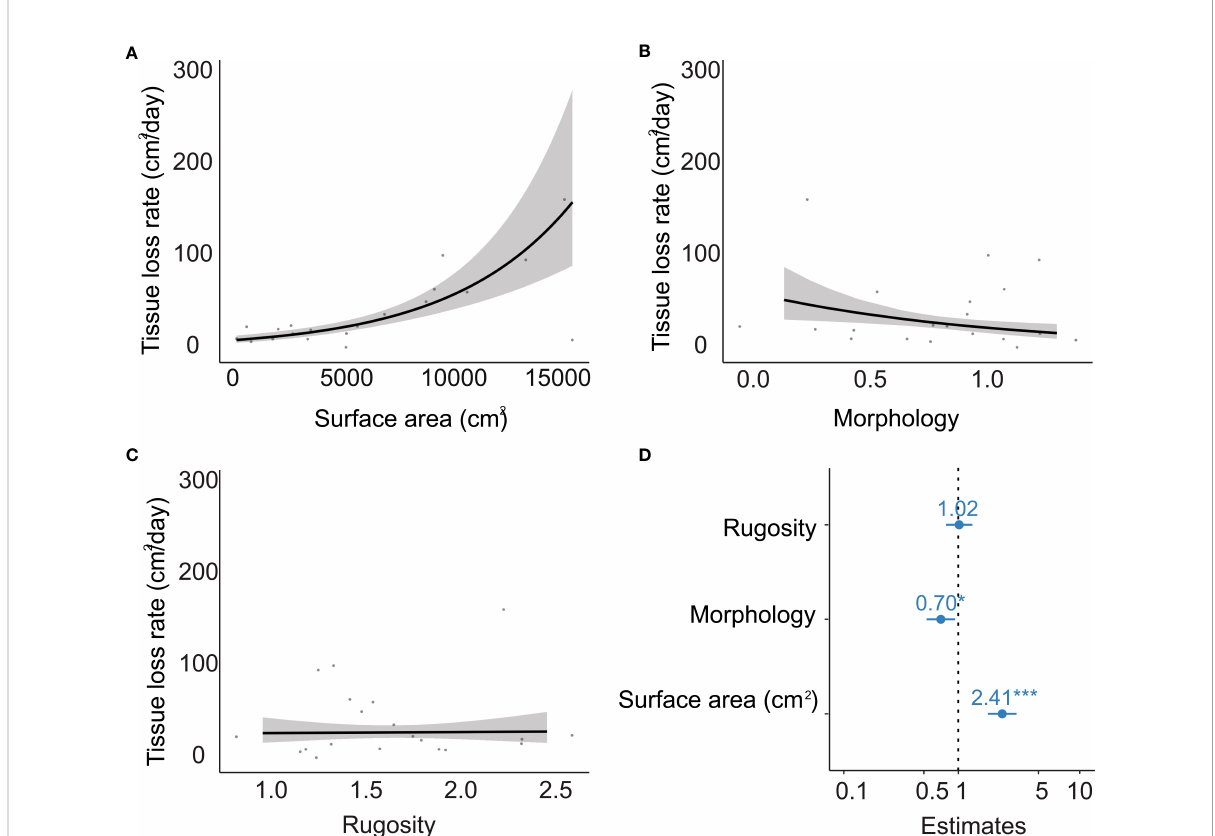
FIGURE 3 Relationship between colony morphology metrics and tissue loss rates (cm 2 /day) in Pseudodiploria strigosa in Limones Reef. (A) Surface area in cm 2 , (B) morphology, which is the integration of colony ’ s height, length and width using the following formula: (width/length) * (width/height), (C) colony rugosity. (D) Effect sizes of tissue loss rate predictors. Estimates are derived from the generalized linear models with the dots and lines representing the means and 95% con fi dence intervals, respectively. All continuous predictive variables were scaled to z-scores with the scale function in